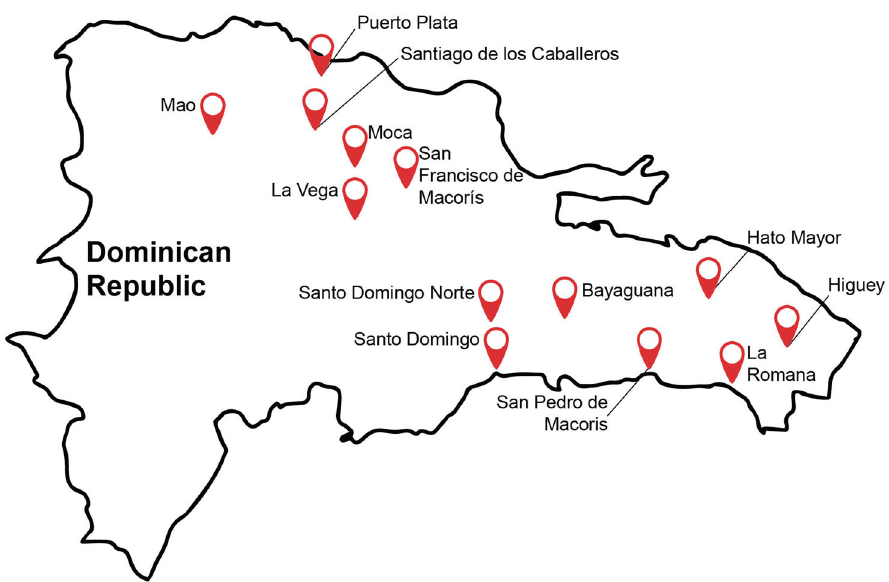
Figure 1. Sample collection sites in the Dominican Republic. Sampling locations throughout the country are marked with a red symbol.